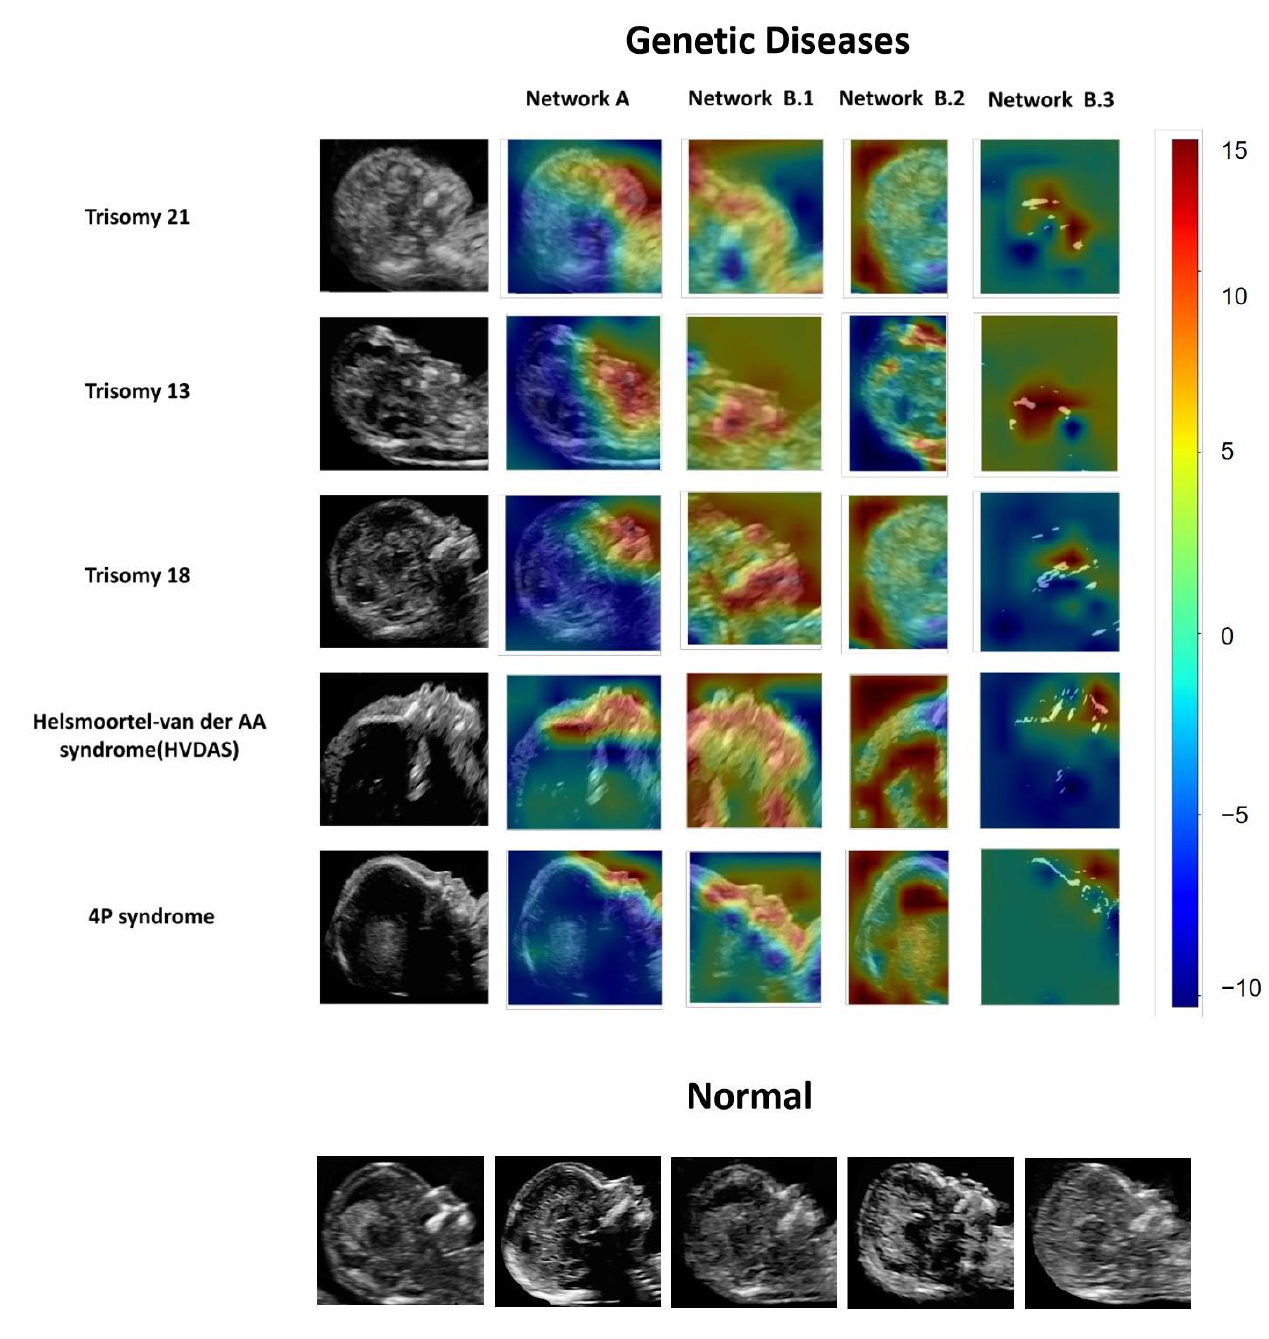
Figure 5. Example of fetal genetic diseases and corresponding heatmaps from Network A and Network B (B.1, B.2, B.3). The heatmap illustrates the importance of local areas within the image for classification. The importance value is scaled between −10 and 15, where a higher number indicates that the area is of higher importance for classifying the image as consistent with genetic diseases.